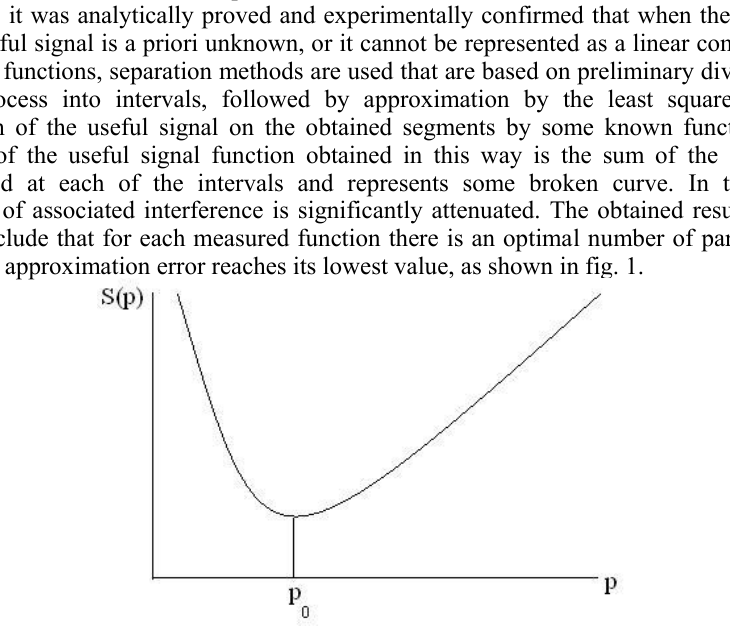
Fig. 1. Determining the sample partitions number of measurement